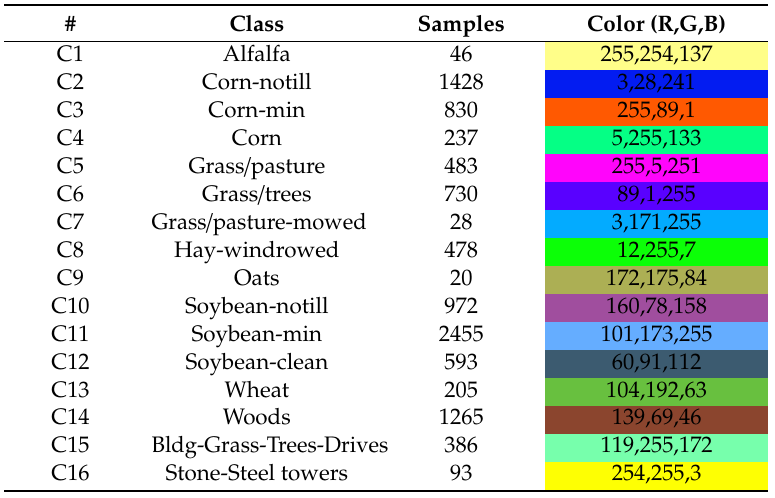
Table 1. Information about the Indian Pines dataset.